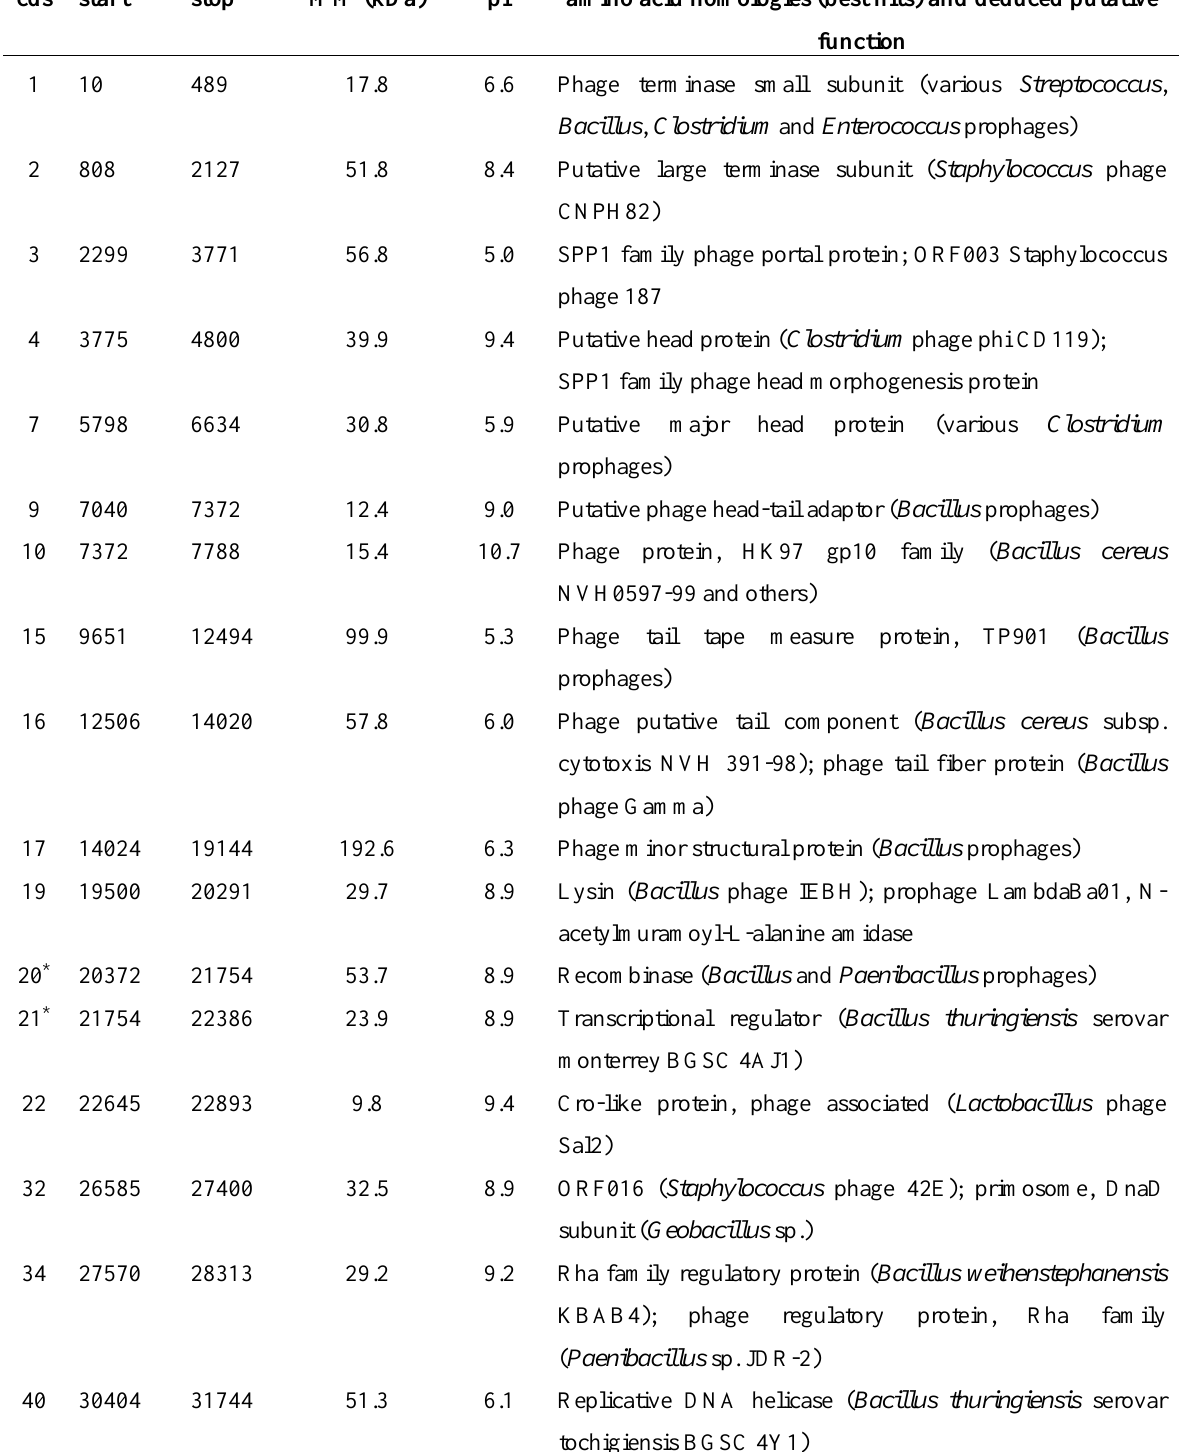
Table 1. General features, database matches and functional assignments of coding sequences (cds) of the Bacillus phage TP21-L genome for which homologies (e-value < 0.01) to known proteins could be found. Molecular mass (MM) and isoelectric points (pI) of the gene products (gp) are indicated. An asterisk indicates transcription on the complementary